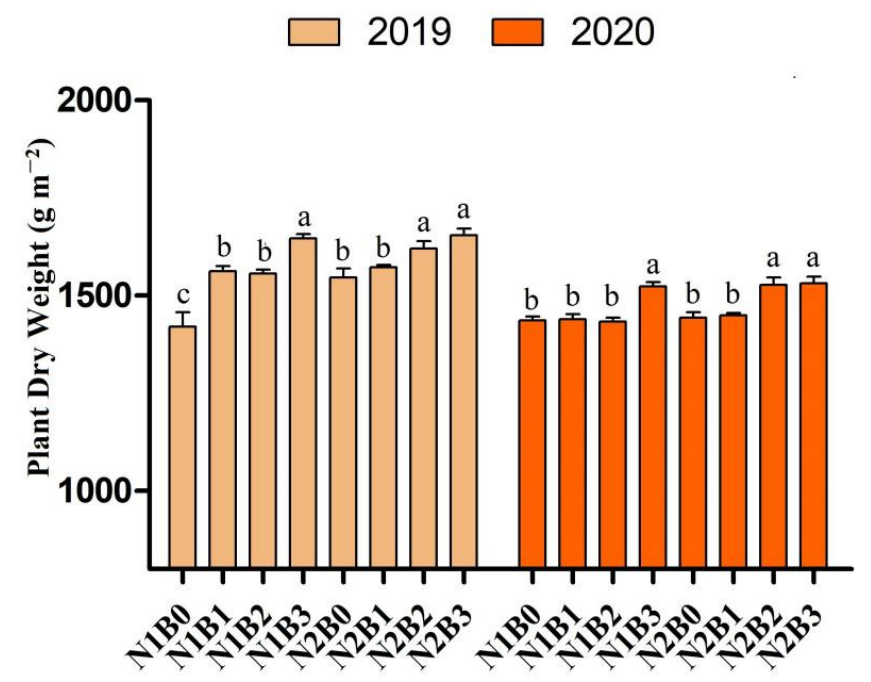
Figure 1. Total biomass production in rice plants under different biochar and nitrogen fertilizer treatments during 2019 and 2020. Different letters on bars are not significantly different at p < 0.05.; Bars indicate means ± SD (n = 3).